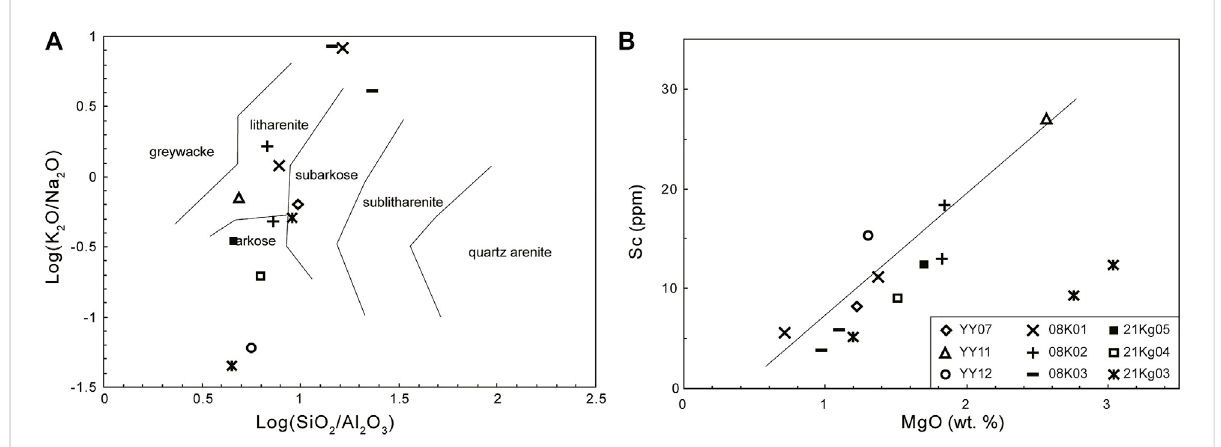
FIGURE 9 Chemical classi fi cation diagrams discriminating sedimentary rocks. (A) SiO 2 /Al 2 O 3 vs. Na 2 O/K 2 O (Pettijohn et al., 1972) and (B) MgO vs. Sc